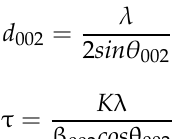
Figure S1: Experimental device for the catalytic cracking of n-dodecane, Figure S2. N2 adsorption–desorption isotherms, Figure S3. XRD patterns of the fresh ACs and ZSM-5 zeolite, Figure S4. X-ray photoelectron spectroscopy survey scans of AC catalysts (B.E. = binding energy), Figure S5. Deconvolution of the XPS C1s spectra of the AC catalysts, Figure S6. Gas formation profiles over ACs and ZSM-5 at 450 ◦ C and 4 MPa, Table S1 Energy-dispersive X-ray analysis (EDX) and surface concentration (at%) determined by XPS of the ACs, Table S2 Lattice